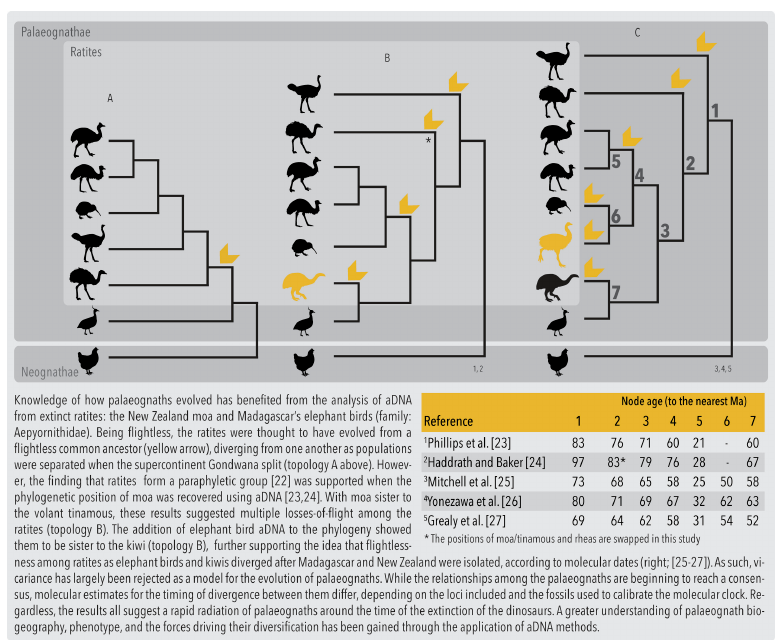
Figure 2. How important is avian aDNA? The palaeognath’s tale. [22–27] .